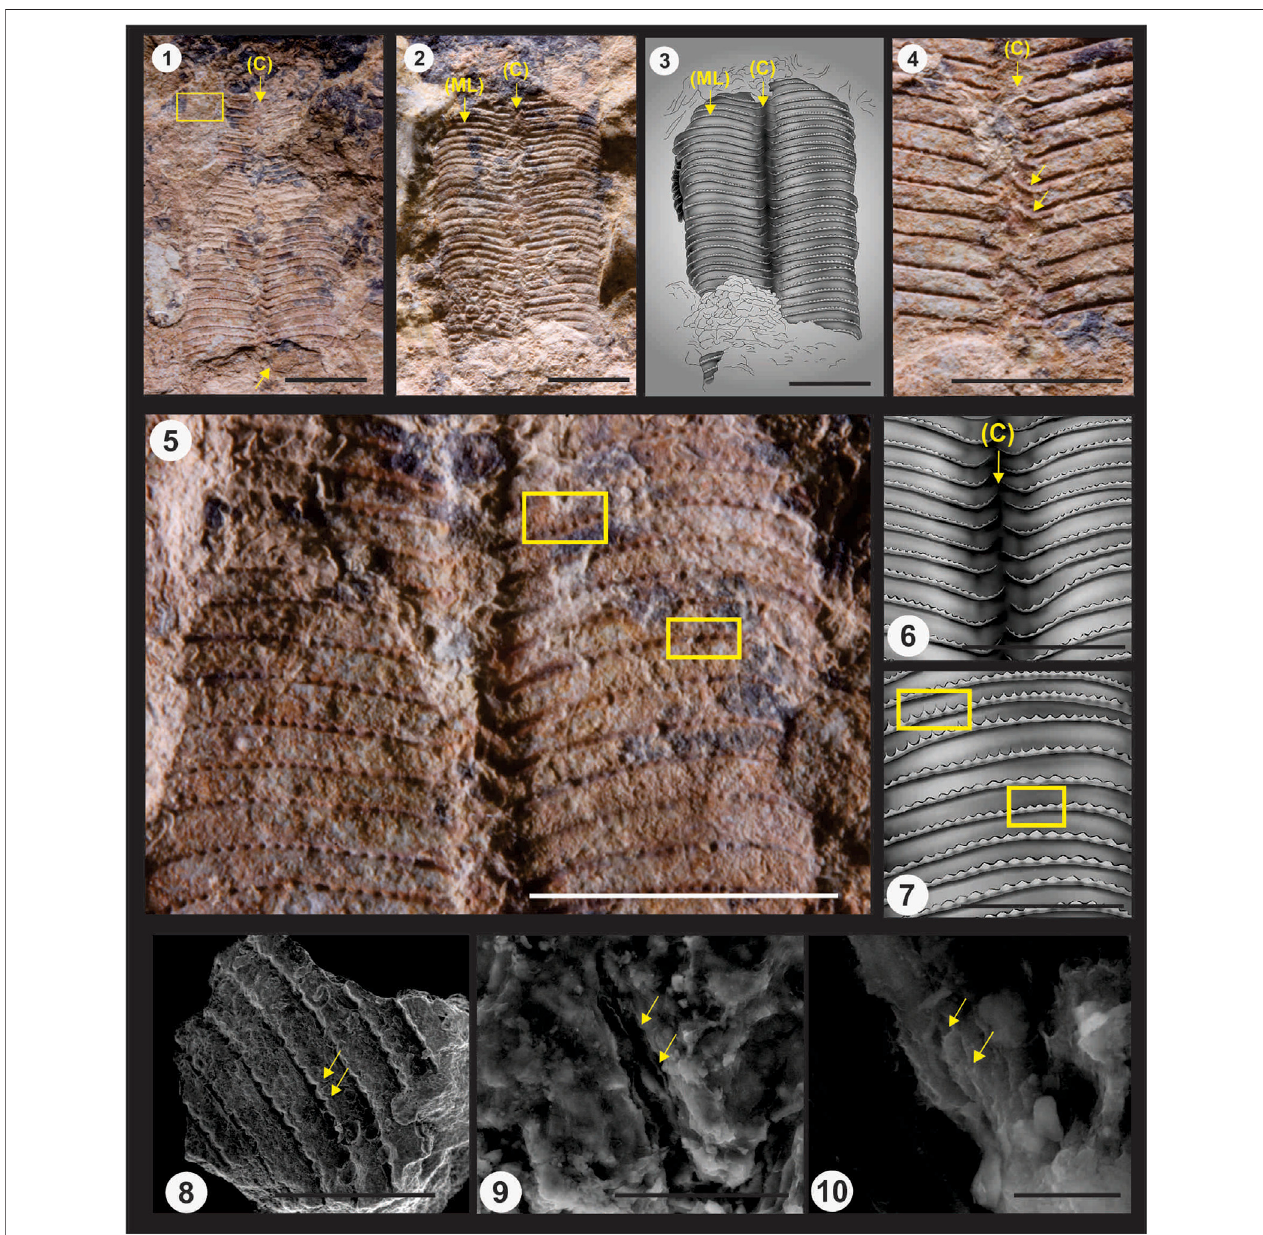
PLATE 1 | Paraconularia ediacara n. sp. (terminal Ediacaran, middle Tamengo Formation, upper Corumbá Group, Mato Grosso do Sul, Brazil; specimen GP-IT 2301, Geosciences Institute, University of São Paulo). 1, 2, color light photographs (both oriented with the apertural end of the fossil at the top); 1, the part, showing the twoexposedpartialfacesandcornersulcus(indicatedbythearrowlabelledC)betweenthem.Thetruncatedapicalendsofthetwomostlycoveredfacesprojectslightly from underneath the truncated apical ends of the two exposed faces (bottom arrow). Open yellow rectangle outlines the area from which the small fragment of periderm for SEM imaging (Figures 8 – 10 below) was extracted; 2, the counterpart (again with the corner indicated by an arrow labelled C, and with one of the facial midlines indicated by an arrow labelled ML); 3, schematic drawing of the part, highlighting the alternation of the nodose transverse ribs in the corner sulcus (C) and the continuation of the transverseribs across the facial midline (ML). 4, 5, color light photographs (both oriented with the aperturalend ofthe fossil at the top); 4, detail of the exposed corner sulcus of the counterpart. Note the pronounced adapertural de fl ection and alternation of the end portions ofthe transverse ribs within the corner sulcus (yellow arrows); 5, detail of the lower (apical) portion of the two exposed faces of the part, showing the widely spaced nodes. Upper rectangle highlights several nodes preservingtheshortinterspace ridgesinpositiverelief,while thelowerrectanglehighlightsseveralnodes showingmuch shorterinterspaceridges;6,schematicdrawing of a portion of the corner sulcus (C) shown in 5; 7, schematic drawing of the facial area with rectangles shown in 5; 8-10, SEM photomicrographs (secondary electron mode)ofasmallfragmentoftheperiderm;8,exteriorsurfaceoftheperiderm,showingseveraltransverseribs,widelyspacednodes,andveryshort,spine-likeinterspace ridges (pointing toward the apertural end of the periderm, yellow arrows); 9, detail of the fragment shown in 8, with canyon-like fractures exposing the edges of several microlamellae (yellow arrows); 10, detail of one of the fractures shown in 9 and exposing microlamellae (yellow arrows). Scale bar: 5 to 8 mm (Figures 1 – 3, 5); 7 mm (Figure 4); 5 mm (Figures 6, 7); 3 mm (Figure 8); 40 μ m (Figure 9); 5 μ m (Figure 10).